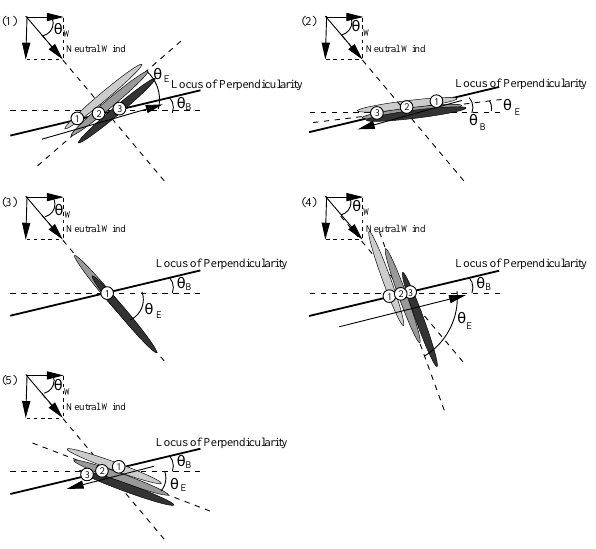
Fig. 12. How one-dimensionally elongated echoing region moves in the horizontal plane along locus of perpendicularity with neu- tral wind. Echoing region is assumed to be at constant altitude of 100km moving with southeastward neutral wind. Angles are mea- sured anti-clockwise from geographic